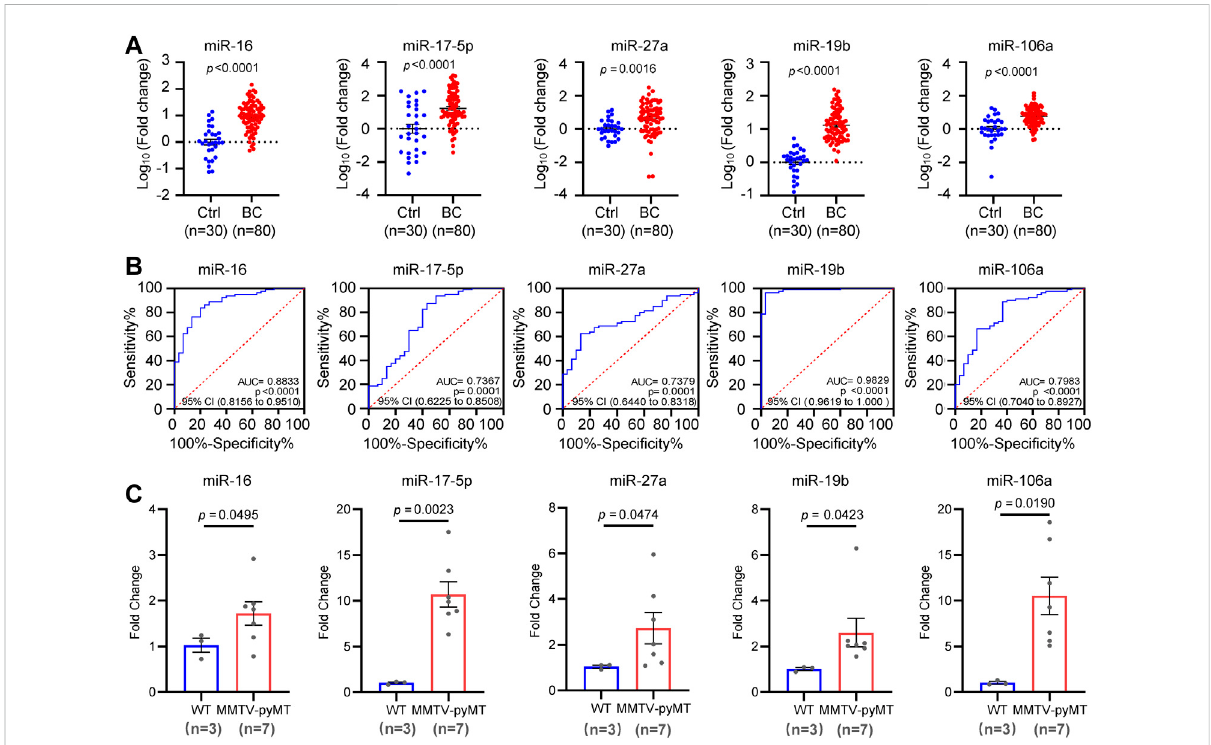
FIGURE 4 Independentvalidation of the fi ve candidate miRNAs. (A) . Expression validation of circulating miR-16, miR-17, miR-27a, miR-19b and miR-106a in an independent cohort including 80 BC patients and 30 controls by quantitative RT-PCR analysis. (B) . Receiver operating characteristic (ROC) curves of miR-16, miR-17, miR-27a, miR-19b and miR-106a in the validation cohort. The values of AUC, 95% CI and p were indicated in the graphs. (C) .UpregulationofmiR-16,miR-17,miR-27a,miR-19b,andmiR-106ainplasmasamplesfromMMTV-PYMTmammarytumormice( n =7)than that in normal controls ( n =